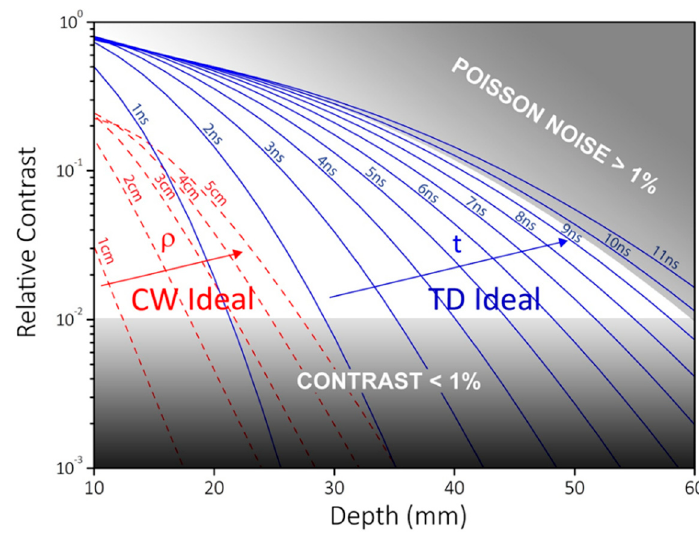
Figure 6. Simulations of the relative contrast produced by a 1 cm 3 optical inhomogeneity as a function of depth z in a tissue-like medium for an ideal time-domain, TD (blue continuous lines) or CW (red dashed lines) system. The detectability region (white zone) is identified by a relative contrast > 1% and a quantum noise < 1%. Reprinted with permission from [61] © The Optical Society.